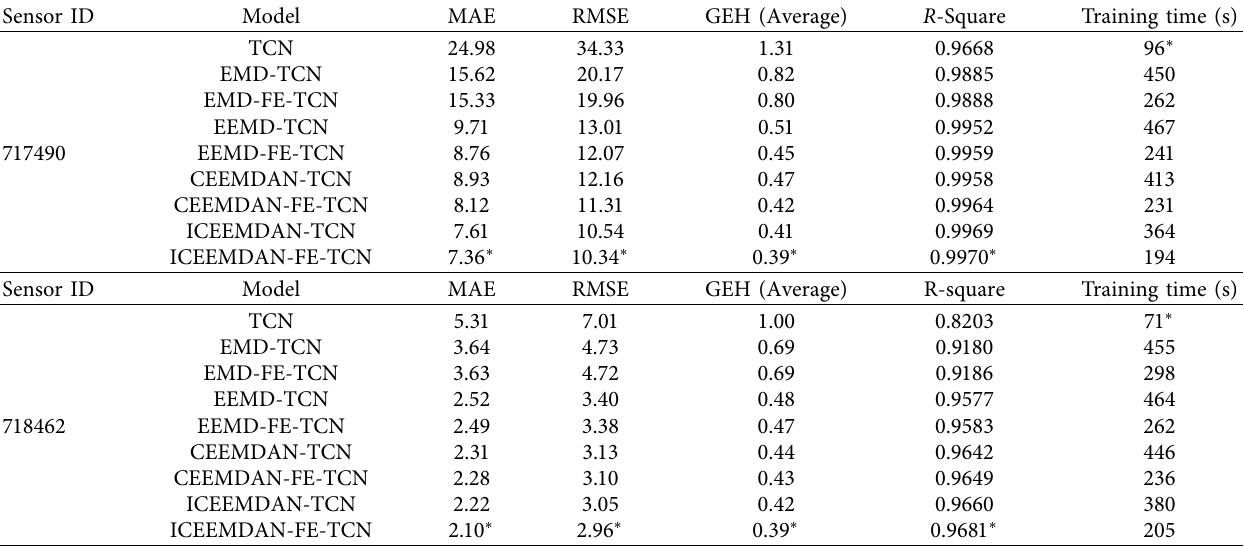
Table 6: Prediction error and training time of different models based on TCN of 717490 and 718462. Sensor ID